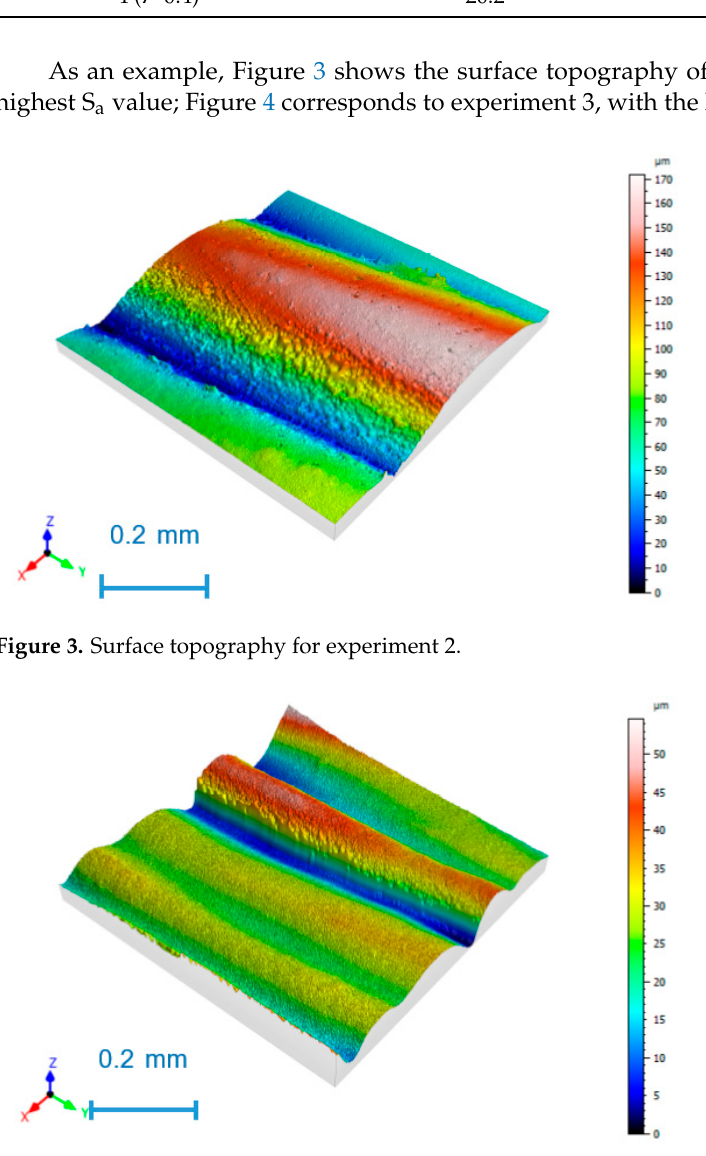
Table 2. Mean and standard deviation (SD) of areal average roughness S a of the printed samples. Experiment